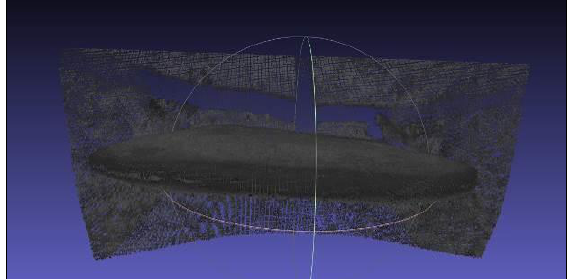
Figure 3. “Escultura 23”. Mantis point cloud with shadow areas resulting in very low point density.